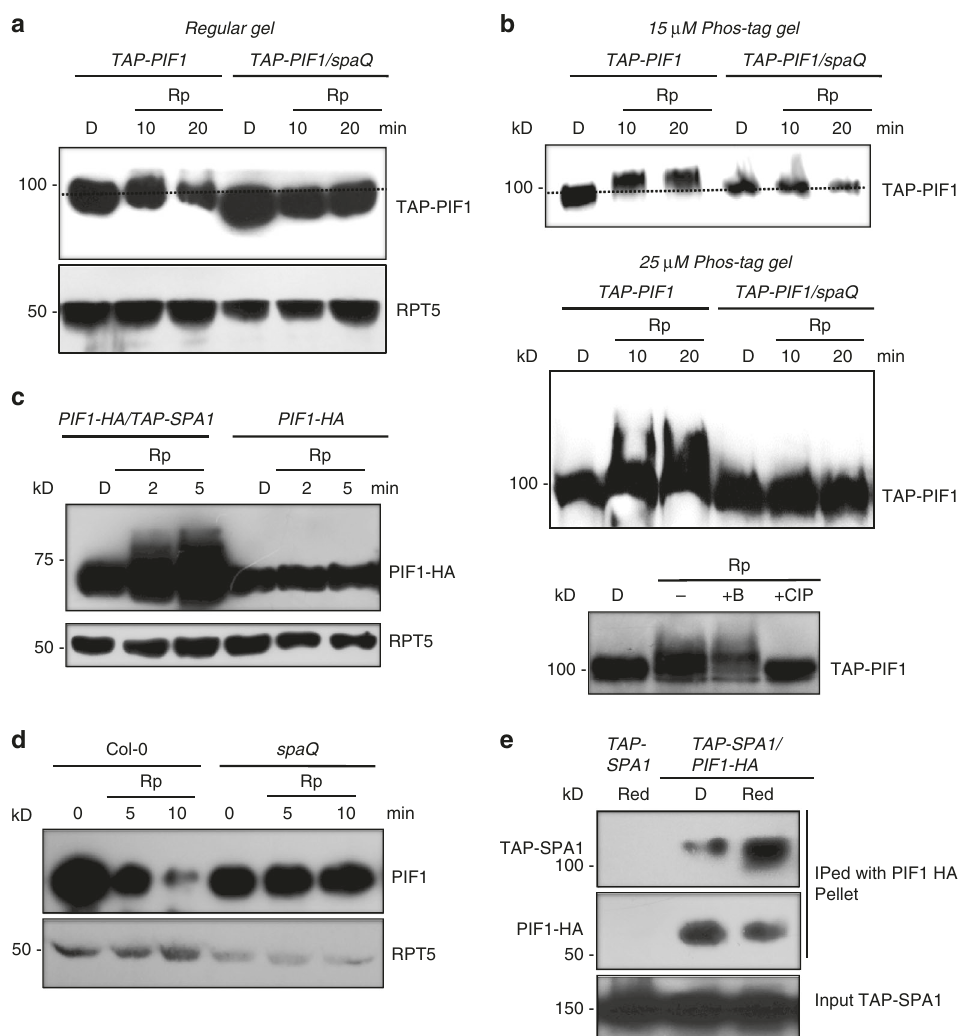
Fig. 2 SPAs are necessary for the light-induced phosphorylation and degradation of PIF1 in vivo. a Immunoblots showing the light-induced phosphorylation of TAP-PIF1 is defective in the spaQ mutant compared to wild type. Four-day-old dark-grown seedlings were either kept in darkness or exposed to a pulse of red light (300 μ molm − 2 ) and then incubated in the dark for the duration indicated before being sampled for protein extraction. All dash lines show the dark position of the PIF1 band. b Immunoblots show a defect in the light-induced phosphorylation of TAP-PIF1 in spaQ background compared to wild type in gels containing 15 (top) and 25 (middle) µ M phostag. (Bottom panel) The red light-induced slow-migrating band is a phosphorylated form of TAP-PIF1 as indicated by the phosphatase treatment. + CIP, native Calf Intestinal Phosphatase; + B, heat-inactivated boiled CIP. c Overexpression of SPA1 induces faster phosphorylation of PIF1-HA than wild type under weak red-light pulse (1 μ molm − 2 ). Seedlings were pretreated with the proteasome inhibitor (40 μ M bortezomib) for 5 h before being exposed to red light. Blots were probed with anti-HA and anti-RPT5 antibodies. d Immunoblots showing native PIF1 level in spaQ mutant compared to wild type. e Immunoblots show that TAP-SPA1 can interact with PIF1-HA in a red light-inducible manner in